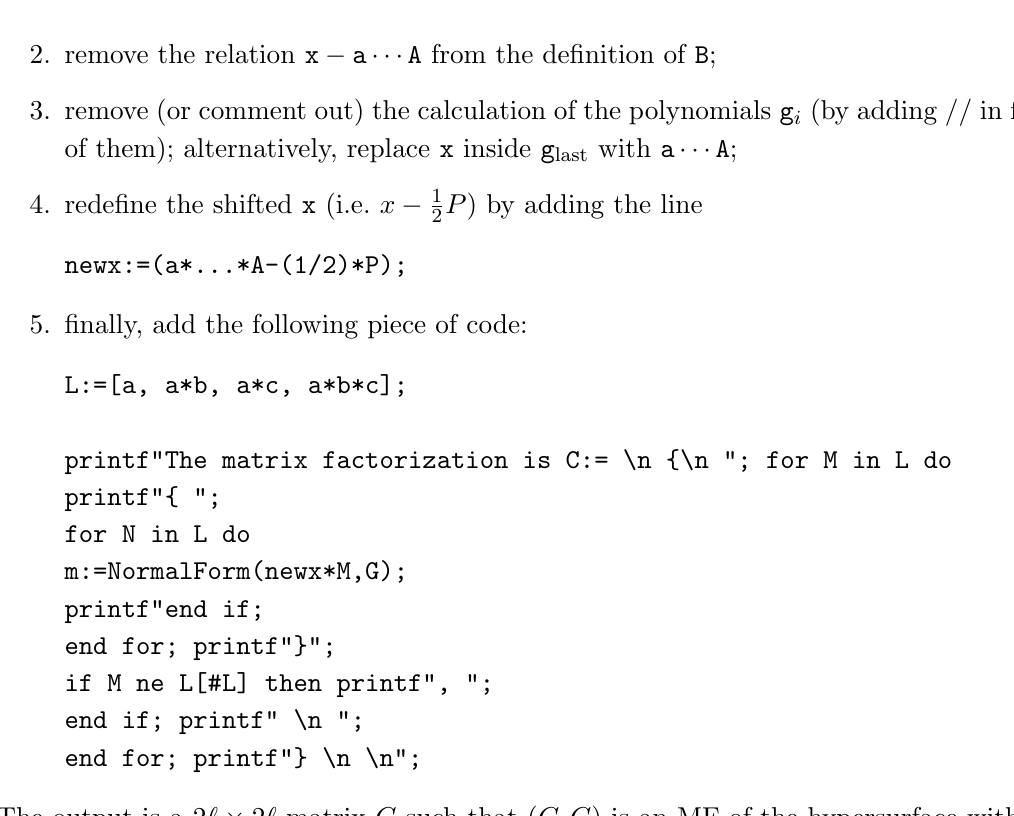
Table 1 . The set of 2 ‘ paths C C ‘ generating the deformation algebra. The ellipsis in the cases ! ‘ = 3 ; 4 ; 5 ; 6 denotes the versal deformation in terms of the T i